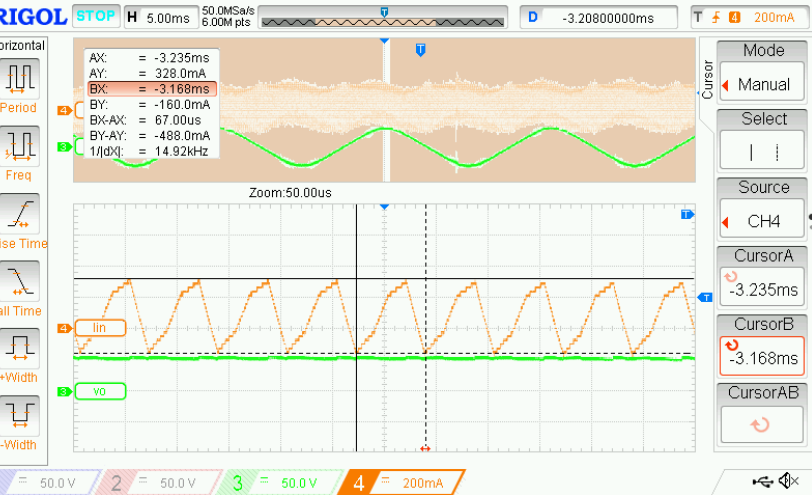
Figure 29. Measurement of output voltage and input current. The ripple in the current waveform demonstrates the 15kHz switching